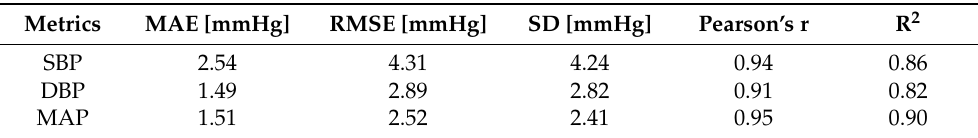
Figure 17. Error grid analysis plot of the MAP (self-made dataset). Table 10. Evaluation metrics for SBP, DBP, and MAP (self-made